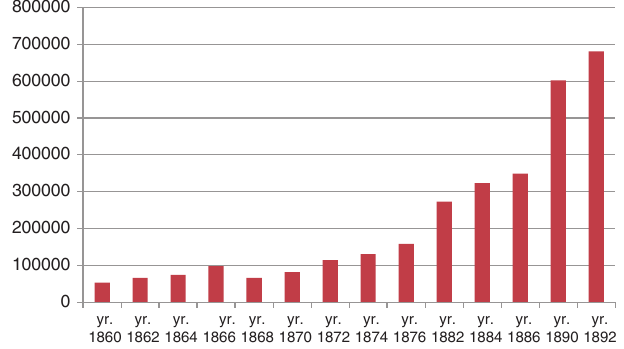
Fig. 1: Number of characters in newspaper GT data for each year.